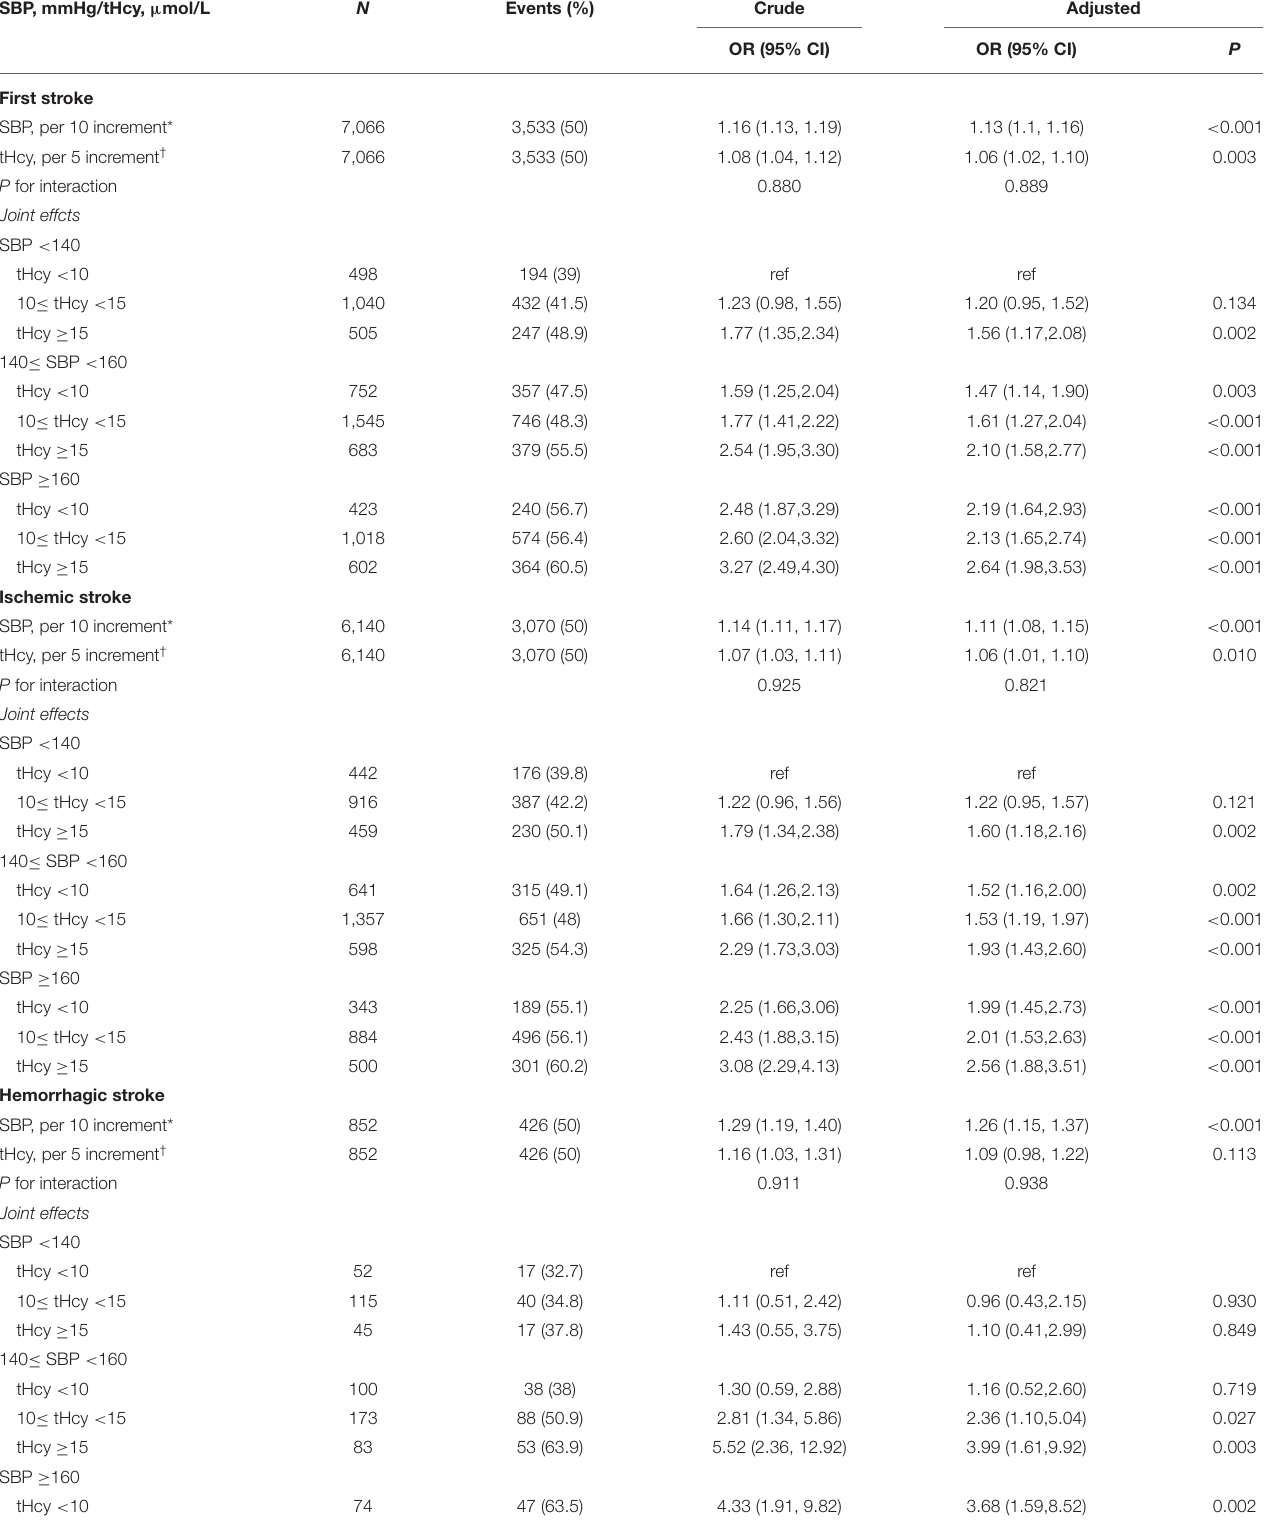
TABLE 3 | Independent and combined effects of systolic blood pressure and homocysteine on first stroke, ischemic and hemorrhagic stroke. SBP, mmHg/tHcy, µ